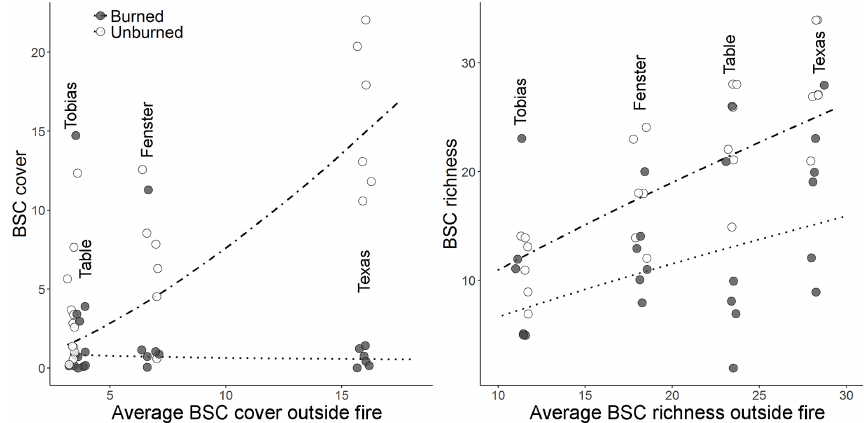
Figure 2. BSC cover and richness at four sites in Idaho, USA, in burned and unburned plots. The x axis represents the covariates average BSC cover and richness in unburned plots at each site, the fitted lines are regressions (details in Table 2), and the labels refer to site names. Table 2. Model details for BSC cover and BSC richness at the four sites in Idaho, USA. Models have the random effect of site and allow variances to differ among treatments. The covariates are average BSC cover and richness in unburned plots at each site. Response